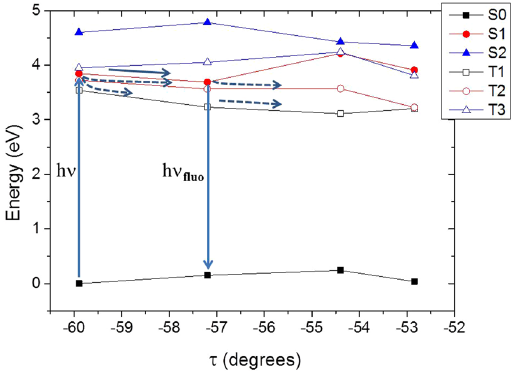
Figure 5. CASPT2//CASSCF MEP of ketoprofen in the S 1 state, along the out-of-plane coordinate τ . TD- DFT and CASSCF results are provided as Supplementary Information and give the same global picture. After